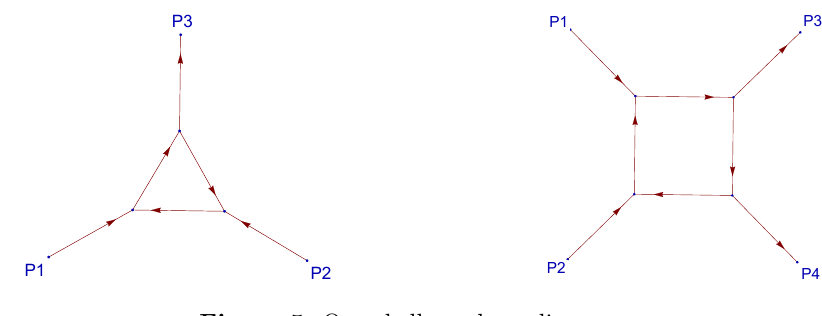
Figure 5 . One-shell one-loop